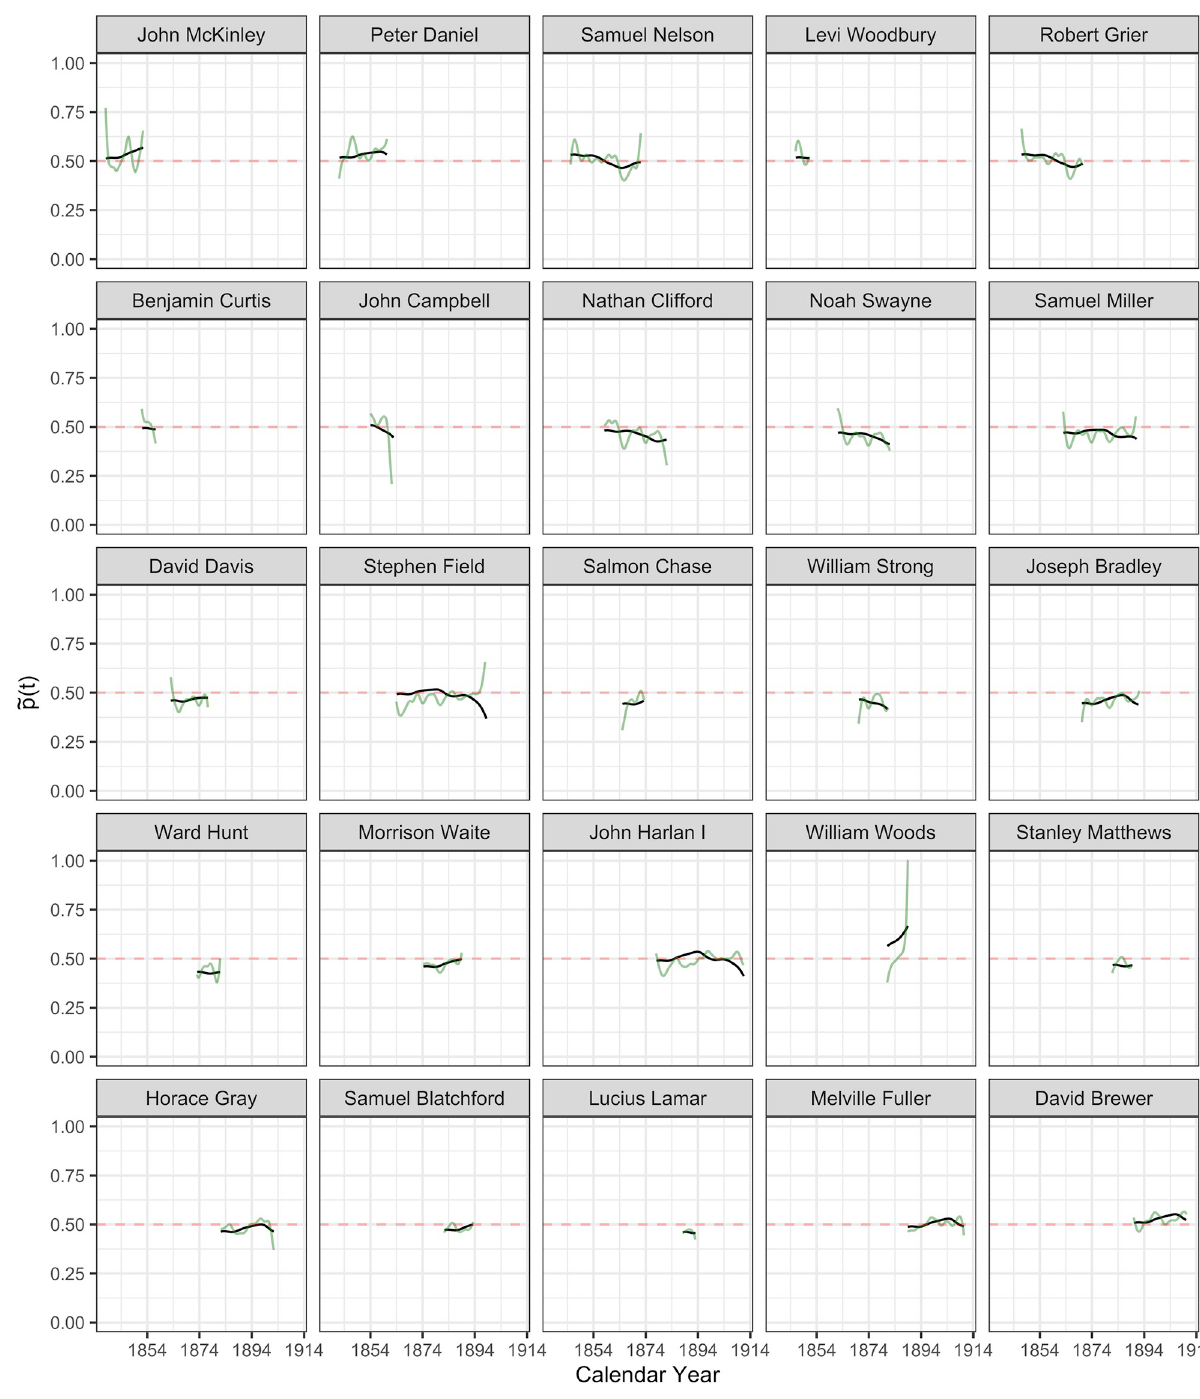
Fig 6. The inferred latent ideology processes ~ p ð t Þ in probability scale, as per Eqs (7) and (8), from John McKinley to David Brewer. Latent i ð t Þ are shown in black and the observed (smoothed) processes ^ p ideology processes ~ p i